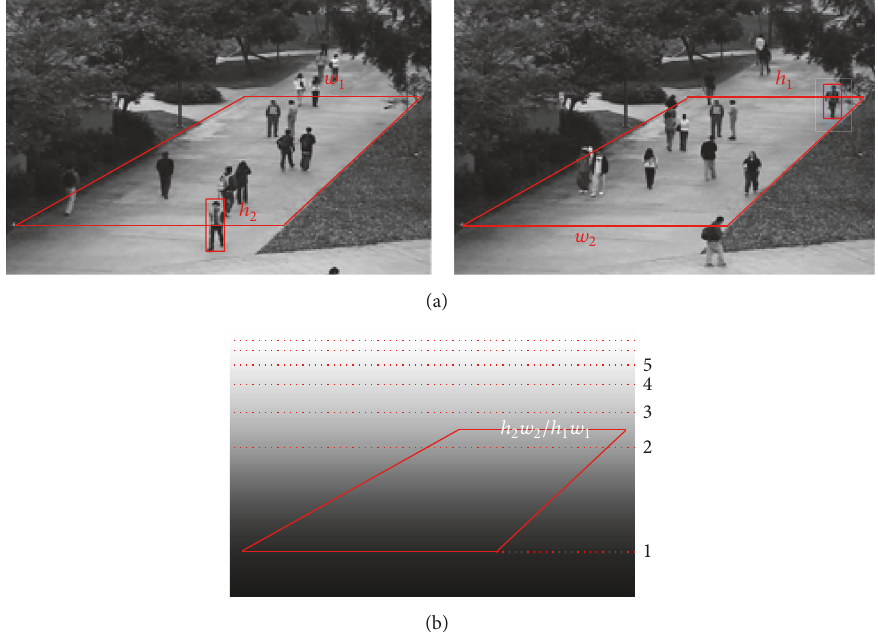
Figure 2: (a) Reference persons at the nearest and farthest point in the labeled ground plane area and (b) the calculated weight